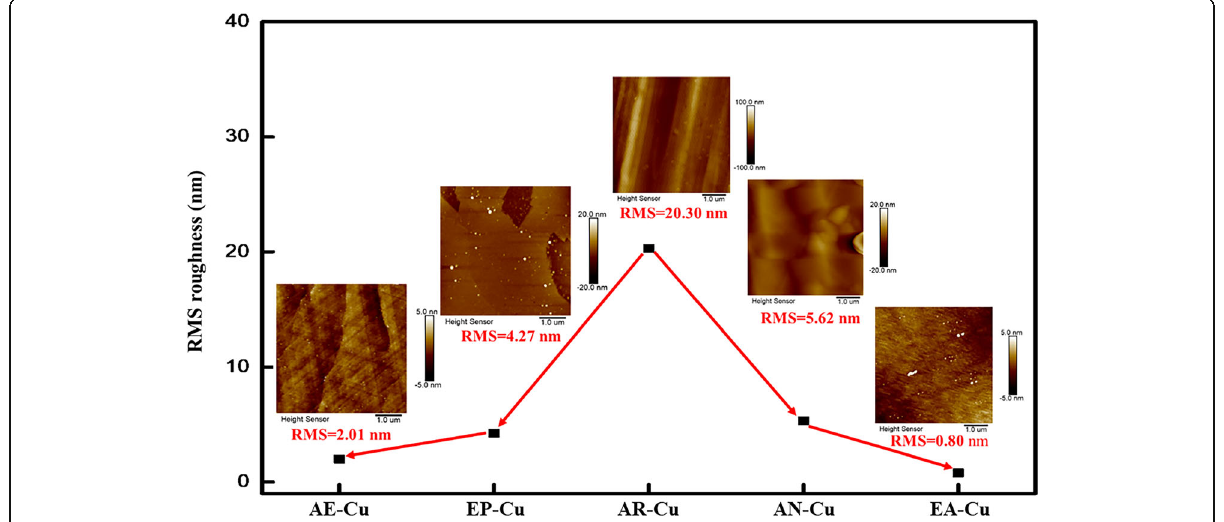
Fig. 2 Average RMS roughness evolution (black squares) of the Cu surface after each processing step obtained in AFM